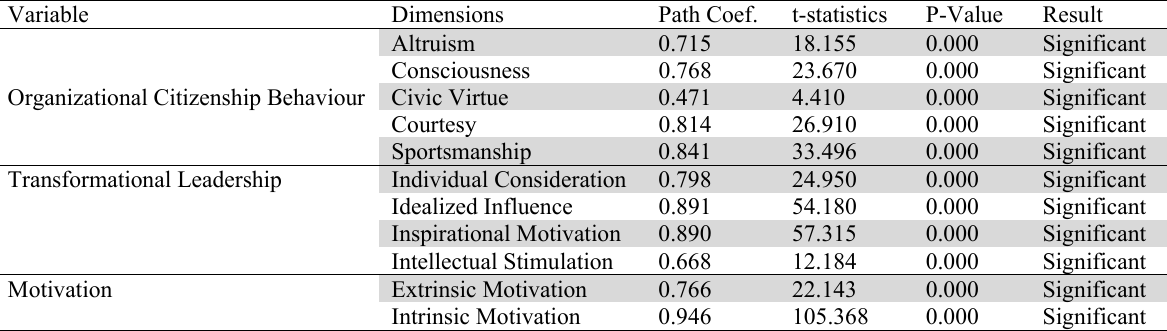
Outer Path Coefficient Variable Dimensions Path Coef.